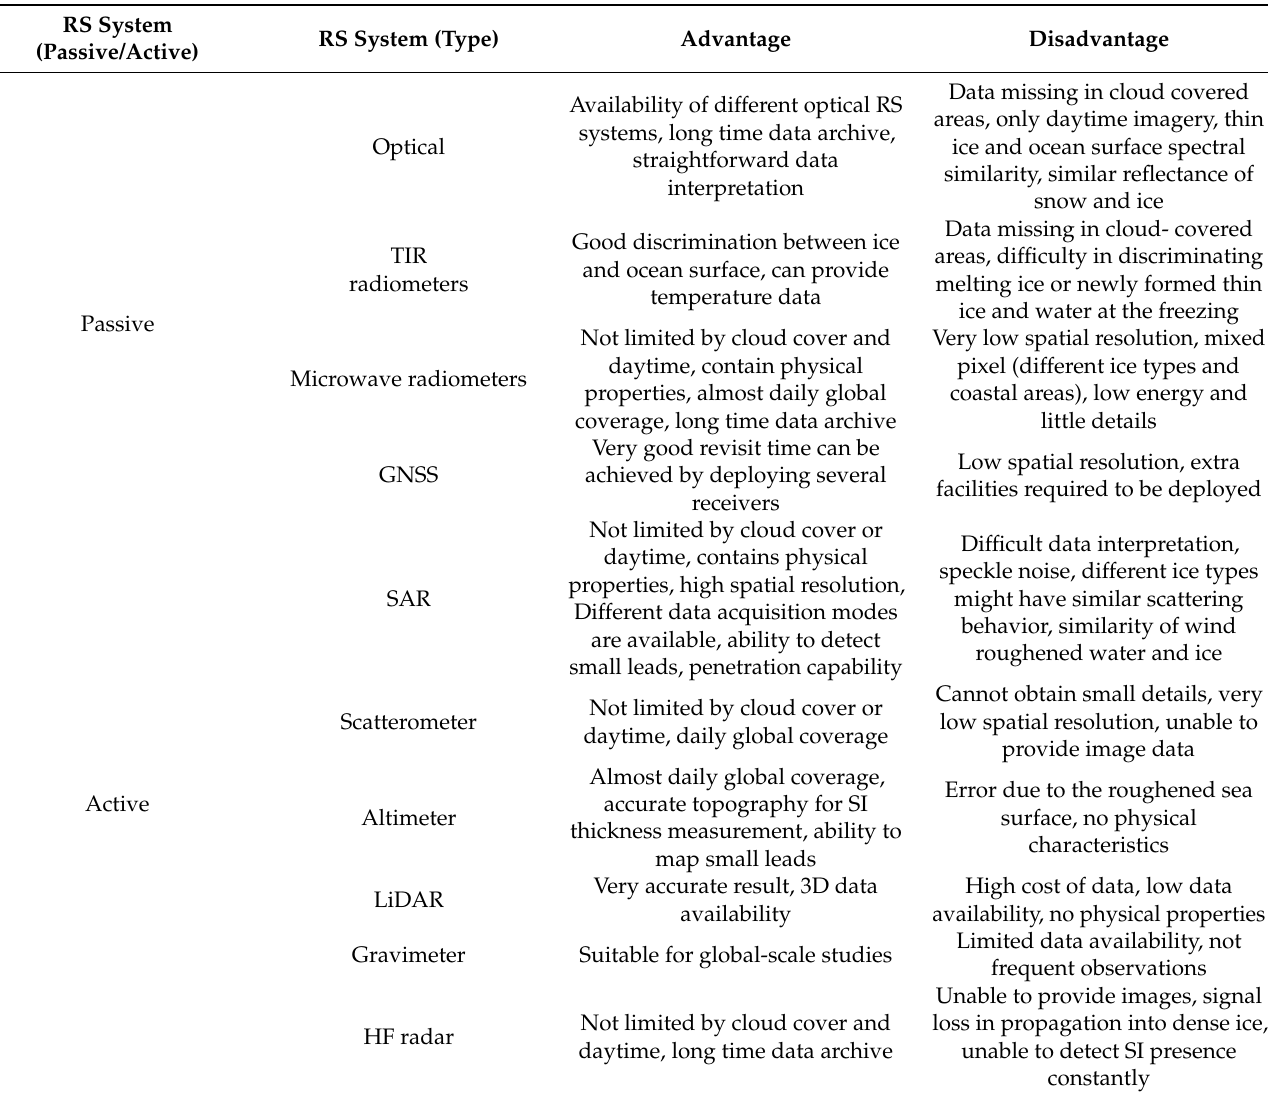
Table 2. Different RS systems for SI studies along with their advantages and disadvantages. RS